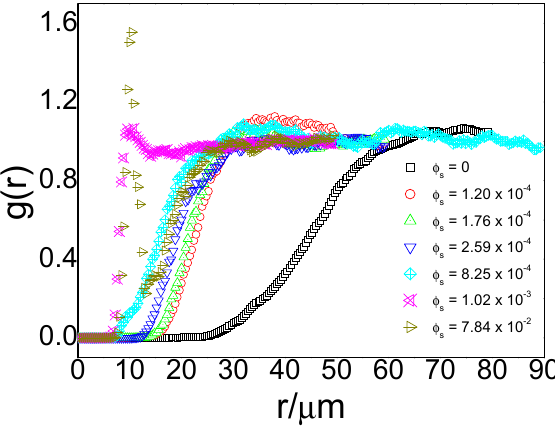
Figure 3. Experimental g(r) of 1-µm PS particles in binary-charged system with different small 0.21-µm PS particle concentration.